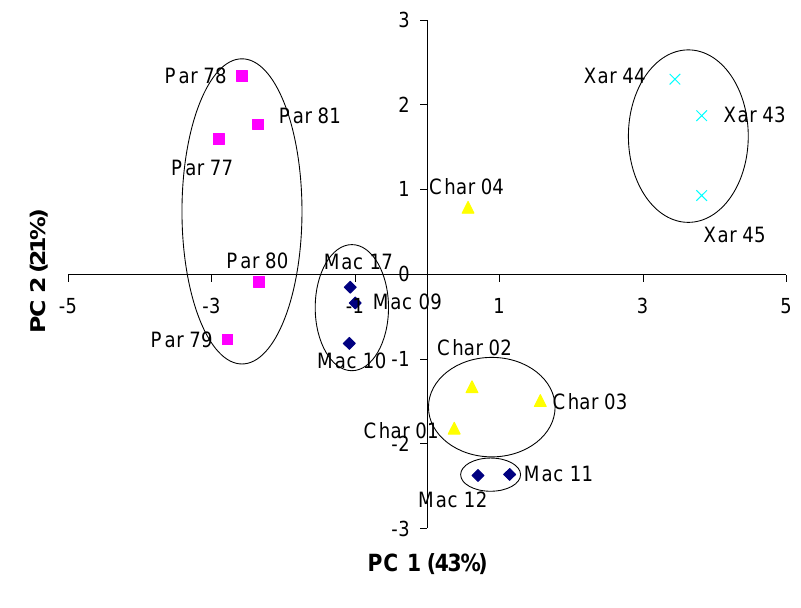
Figure 6. PCA scores plot for the monovarietal Catalan wines using the chemical and optical parameters determined by standard methods of